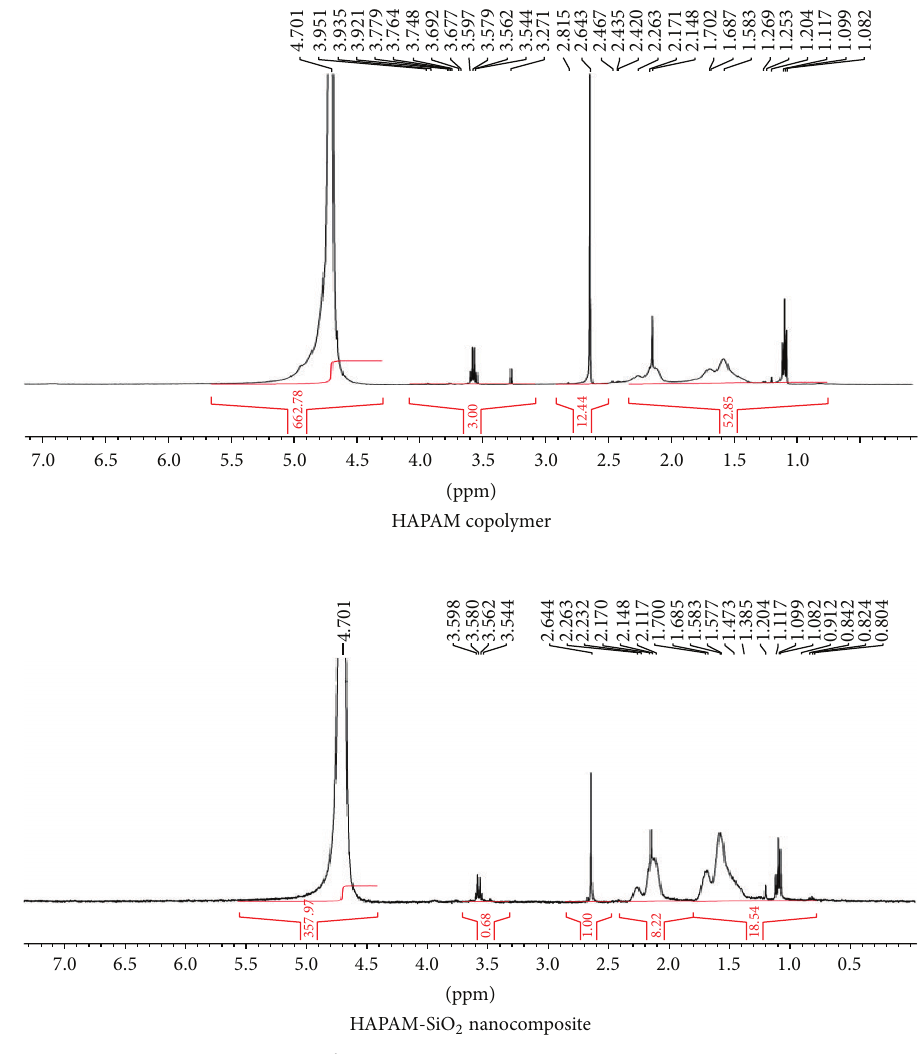
Figure 5: Proton 1 H-NMR spectra of HAPAM and HAPAM-SiO 2 .